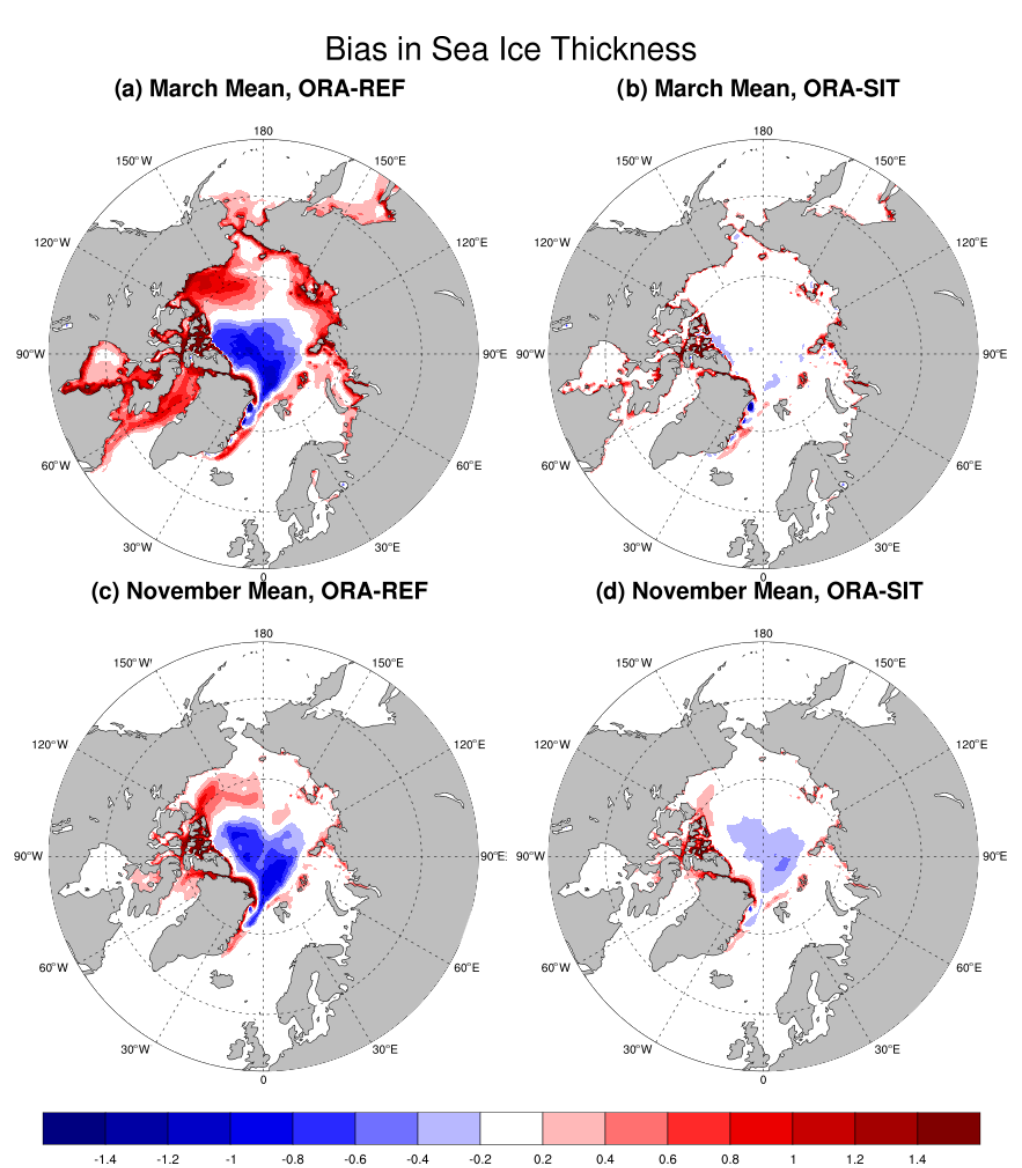
Figure 1. Bias in monthly-mean (2011–2016) sea ice thickness (m) in experiment (a) ORA-REF and (b) ORA-SIT for March (a, b) and November (c, d) . The reference is CS2SMOS observations. ORA-REF is the ocean–sea-ice assimilation experiment with no sea ice thickness constraint. ORA-SIT is the assimilation experiment with a thickness relaxation timescale of